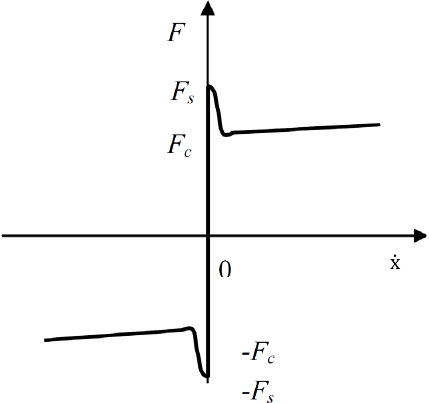
Figure 3. Stribeck friction model (Armstrong-Helouvry, 1993).